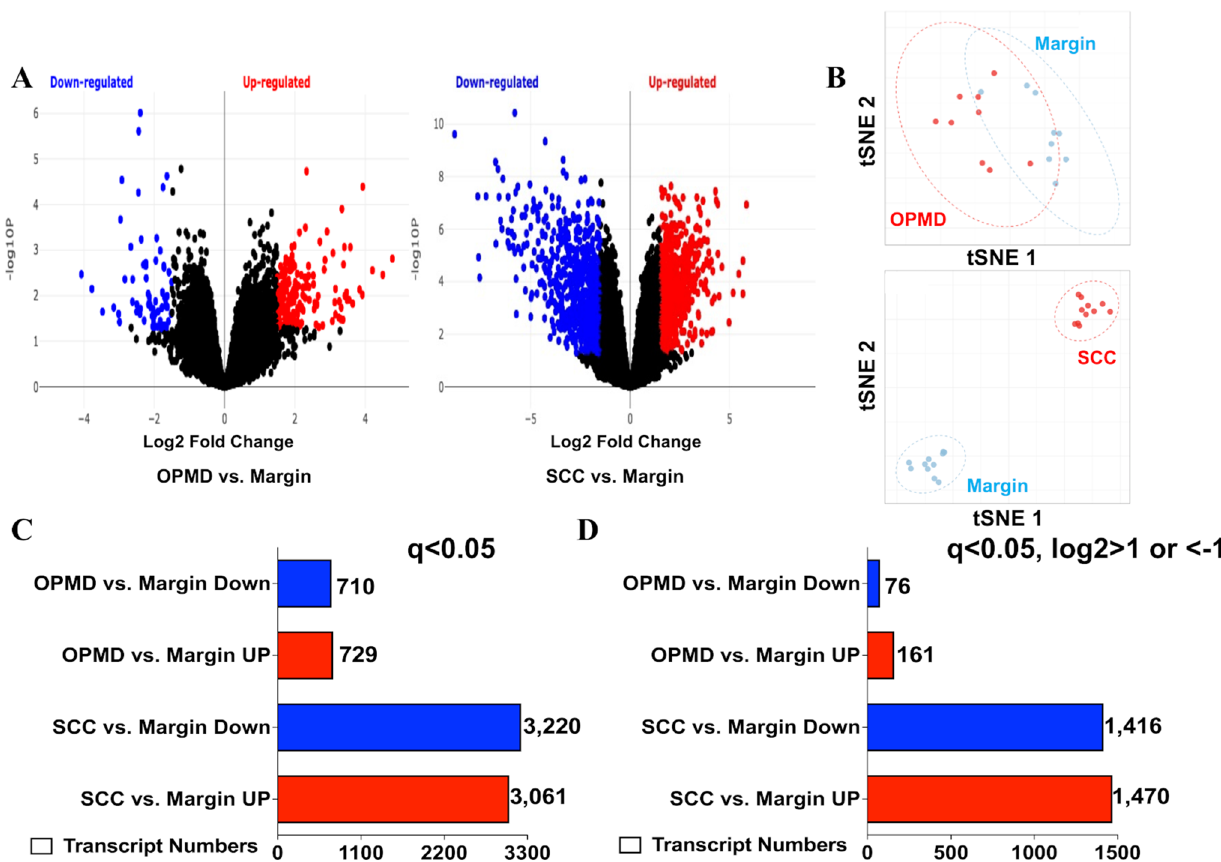
Fig. 1 Comparison of transcriptomes between human tongue oral potentially malignant disorders (OPMD), squamous cell carcinoma (SCC), and margins. A Volcano plot showing total numbers of transcripts with statistically significant increases or decreases (q < 0.05) in the OPMD (n = 9) and SCC (n = 12) compared with the margin group. B tSNE (t-distributed stochastic neighbor embedding plot showing that OPMD is an intermediate state between margin (healthy state) and SCC (cancer state). C Numbers of transcripts significantly (q < 0.05) altered OPMD and SCC, vs. margin. D Numbers of transcripts significantly (q < 0.05) altered OPMD and SCC, vs. margin, with log2 changes > 1 or < −